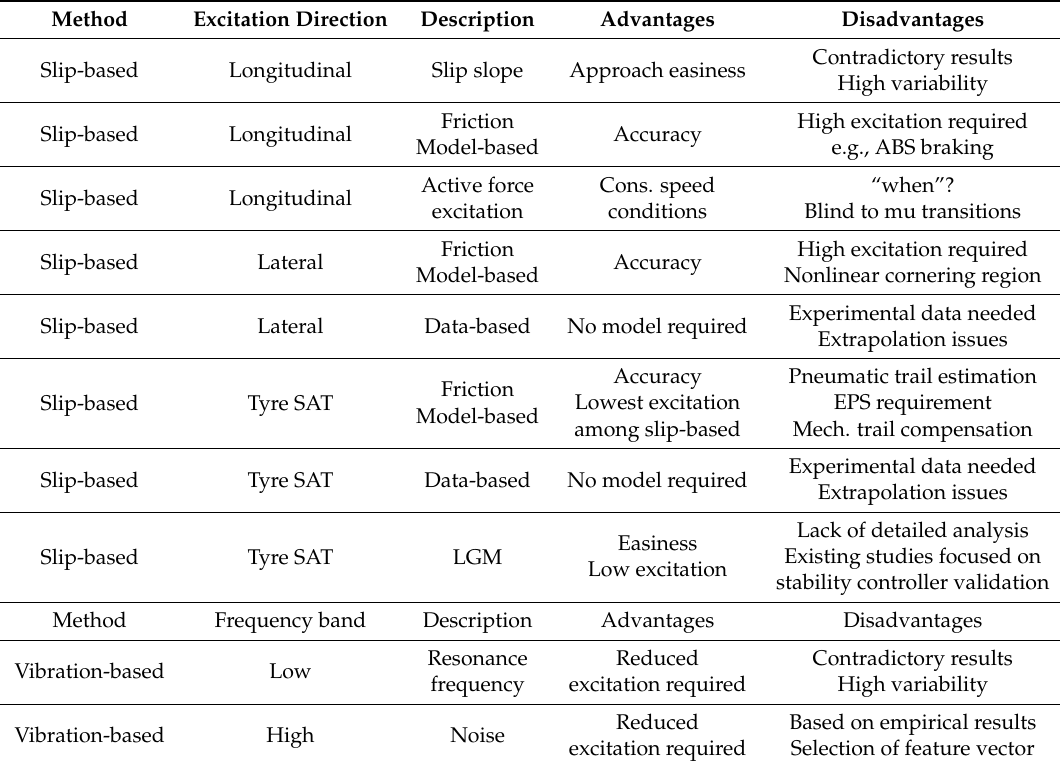
Table 8. Major advantages and disadvantages of the approaches presented in this